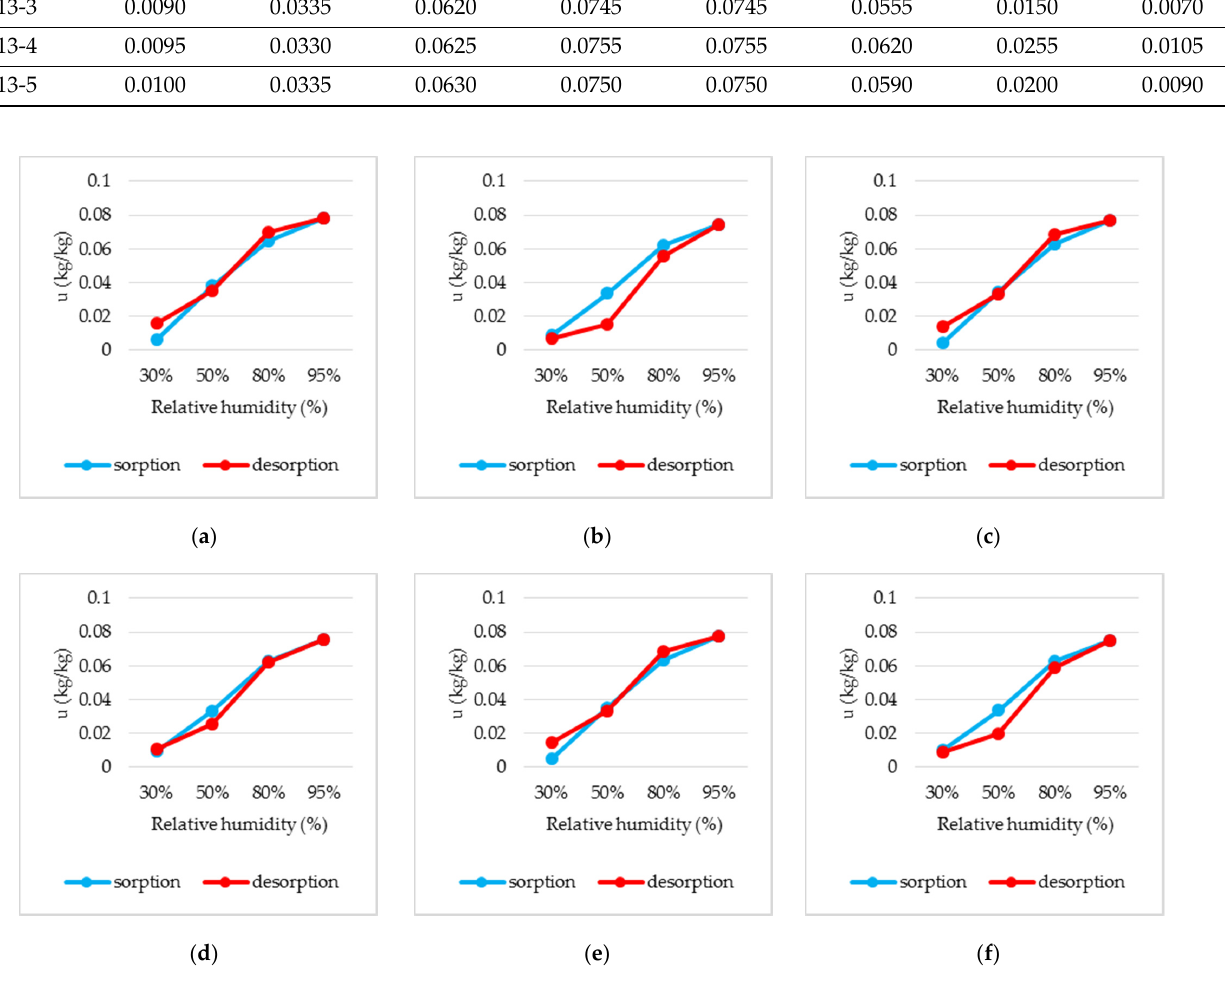
Figure 18. Sorption and desorption curves for: ( a ) P3-3 (wool–latex, thickness 3 cm); ( b ) P13-3